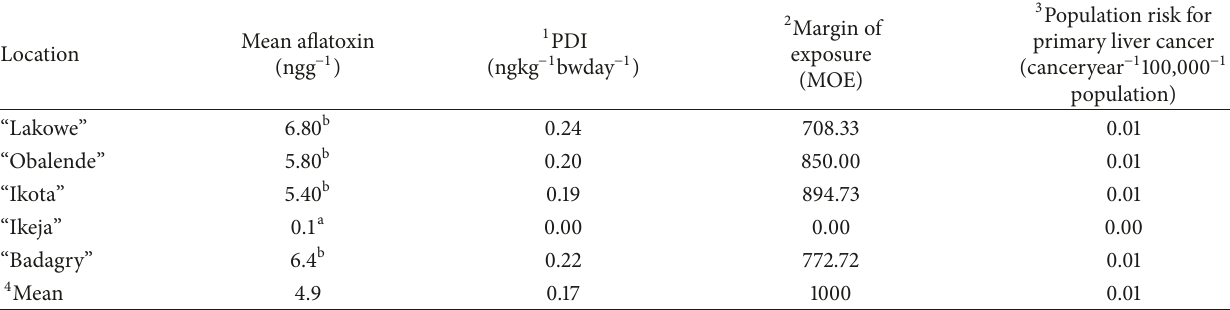
Table 8: Risk Assessment due to consumption of cashew nuts from Lagos State, Nigeria.